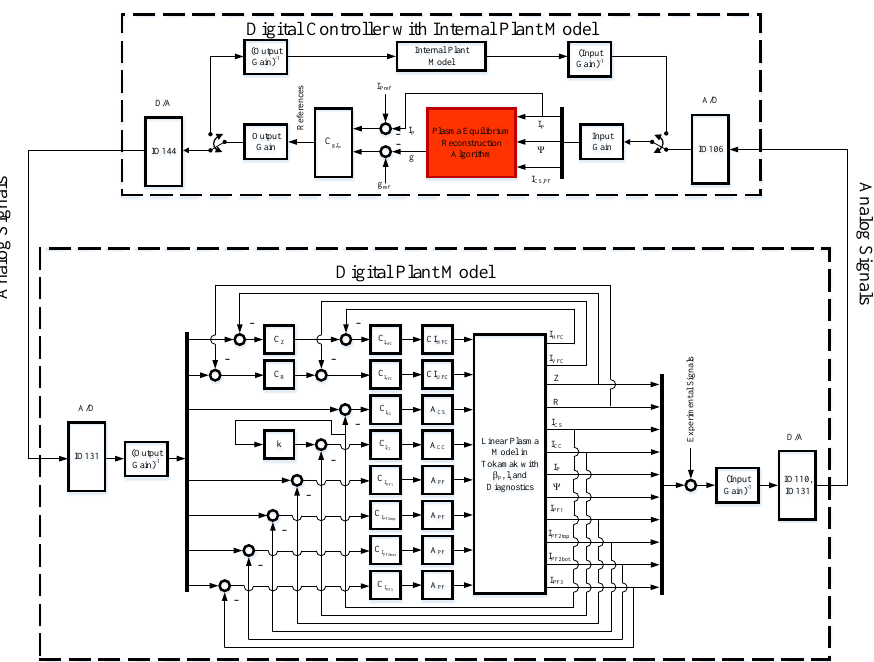
Figure 15. Scheme of digital twin of Globus-M2. The block with plasma equilibrium reconstruction algorithm is marked by red